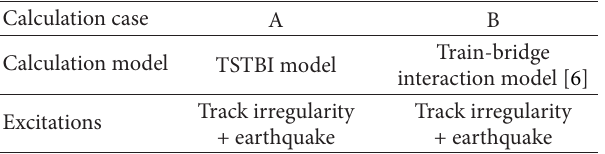
Table 4: (1) both the maximum values of the PSD and